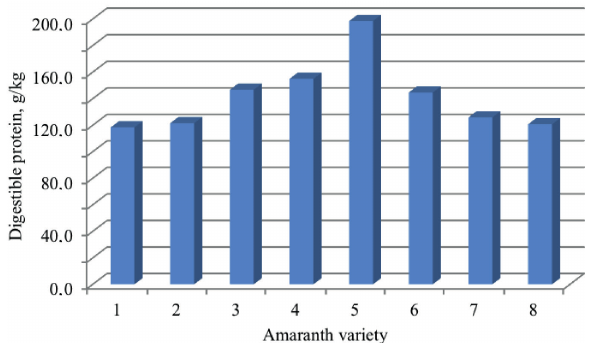
Figure 1 Digestible protein content in amaranth grain